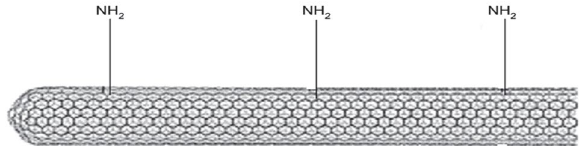
Figure 2. The structure of amino carbon nanotubes.